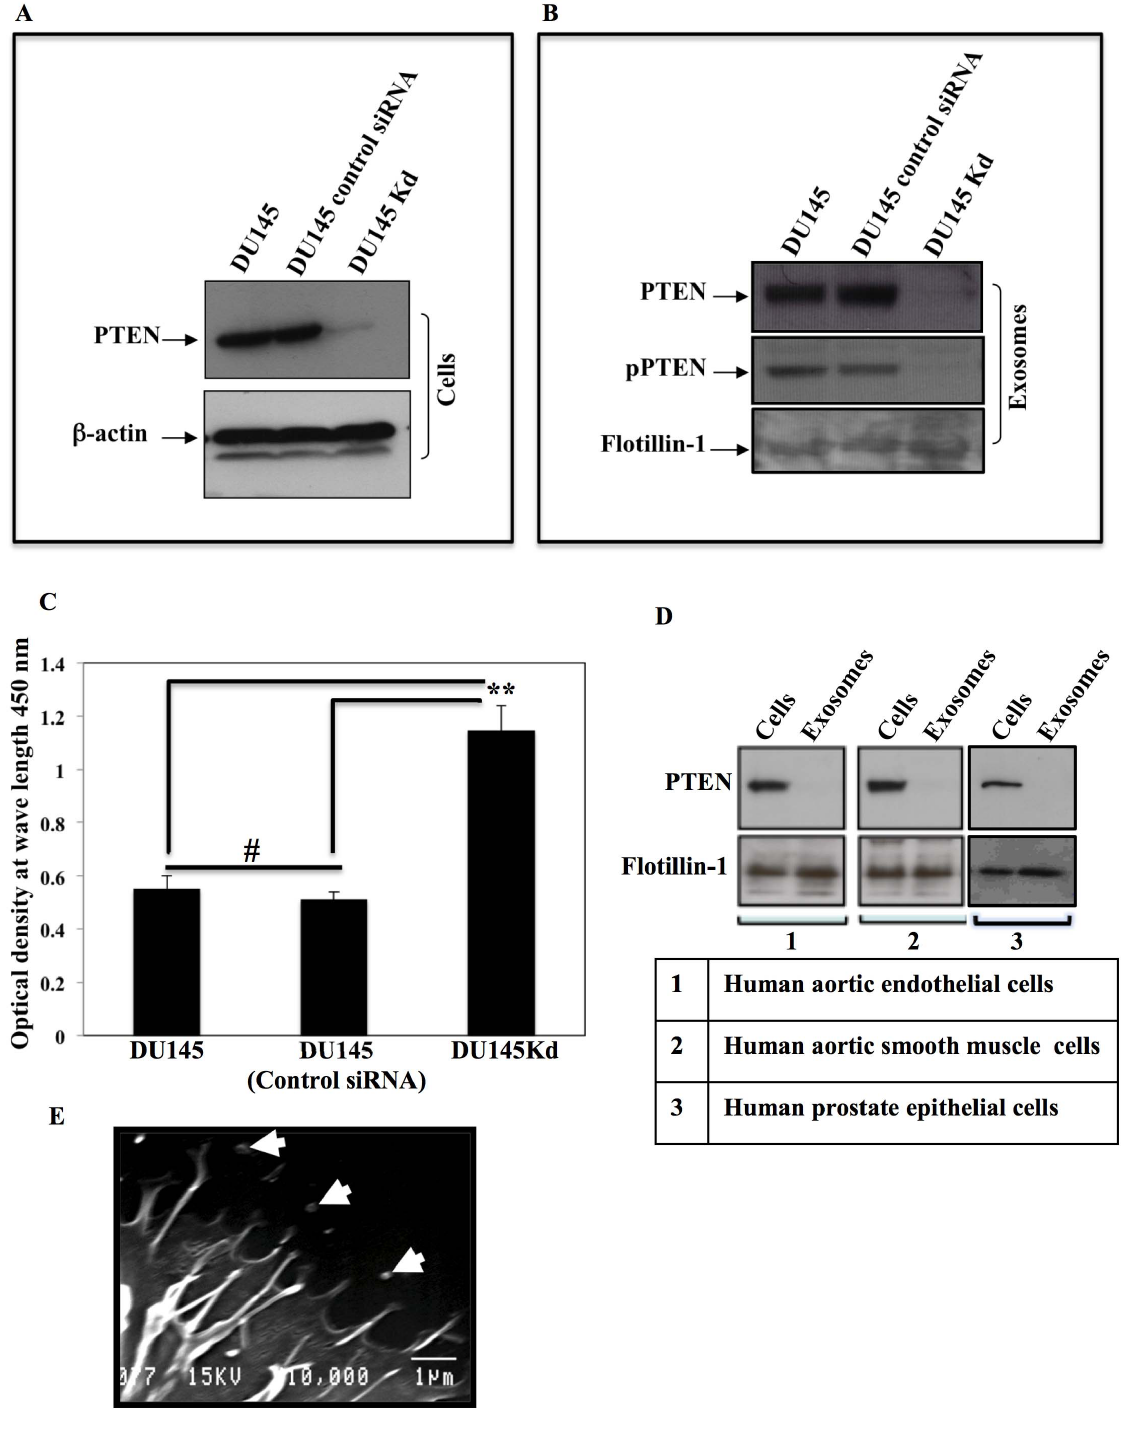
Figure 1. Prostate cancer cells produce exosomes containing PTEN. A. DU145 PC cells were transfected with the indicated siRNA. The cells transfected with PTEN-specific siRNA showed a clear knockdown of PTEN expression, while cells transfected with control mismatch siRNA showed no decrease in PTEN expression. B. Exosomes derived from DU145, DU145Kd, and DU145 with control siRNA show the same pattern of PTEN expression as observed with the cell from which they originated. PTEN incorporated in exosomes is phosphorylated; phosphorylation protects PTEN from degradation, and it can be activated by dephosphorylation upon transfer to other cells. Exosomes are positive for Flotilin-1. C. Differences in proliferation of DU145, DU145 with control siRNA and DU145Kd were assessed, with significantly higher proliferation exhibited by DU145Kd. D. Human primary cells, HAEC, HASMC and HPEC, and their exosomes were profiled for PTEN expression. All three cells have PTEN expression, but PTEN is not expressed in their exosomes. The expression for both cells and their exosomes was normalized with Flotilin-1. E. A scanning electron micrograph showing the shedding of exosomes from DU145 cells.